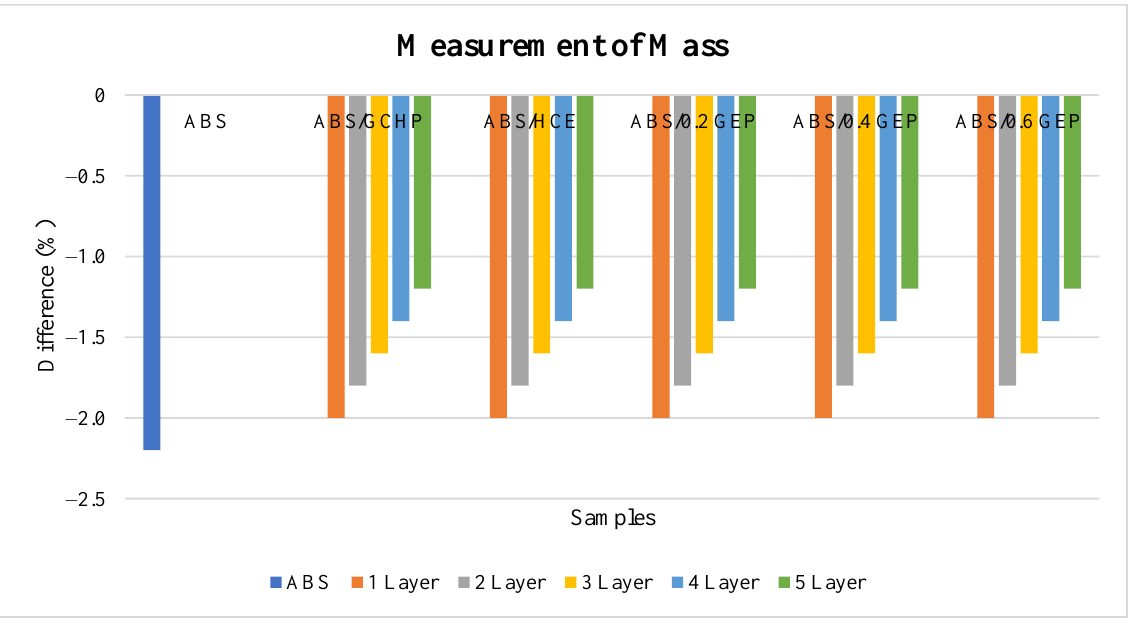
Figure 4. Percentage differences of mass measurements for ABS-based plastic composites.